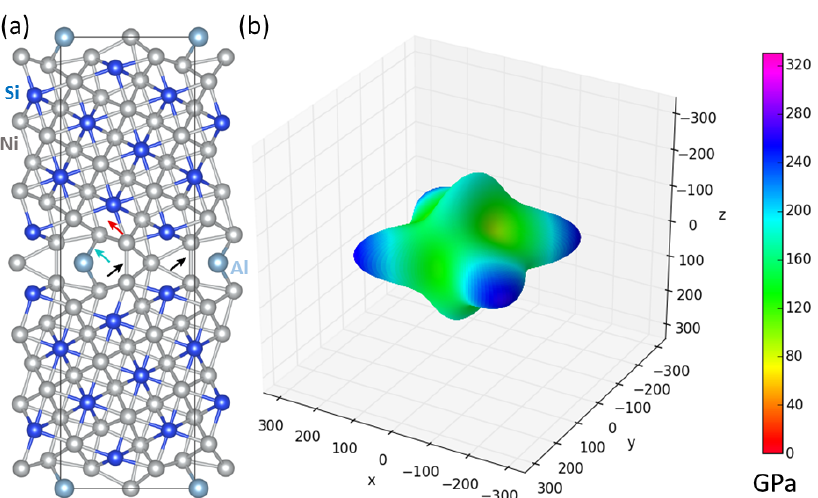
Figure 3. ( a ) Schematic visualization of the supercell of the Σ 5(210) Si,Ni interface state with Si atoms at the interface plane substituted by Al atoms and ( b ) corresponding directional dependences of the Young’s modulus. The latter was computed and visualized by the SC-EMA [80–82] library (scema.mpie.de) based on quantum-mechanically computed elastic constants (Tables 2 and A1 in the Appendix A). Arrows indicate specific inter-atomic bonds discussed in the text (see